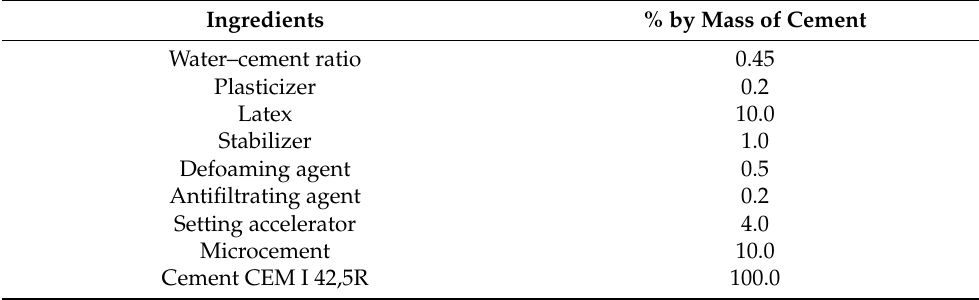
Table 2. Recipe and parameters of the cement slurry used in the adhesion test on the hardened cement–rock contact [34].